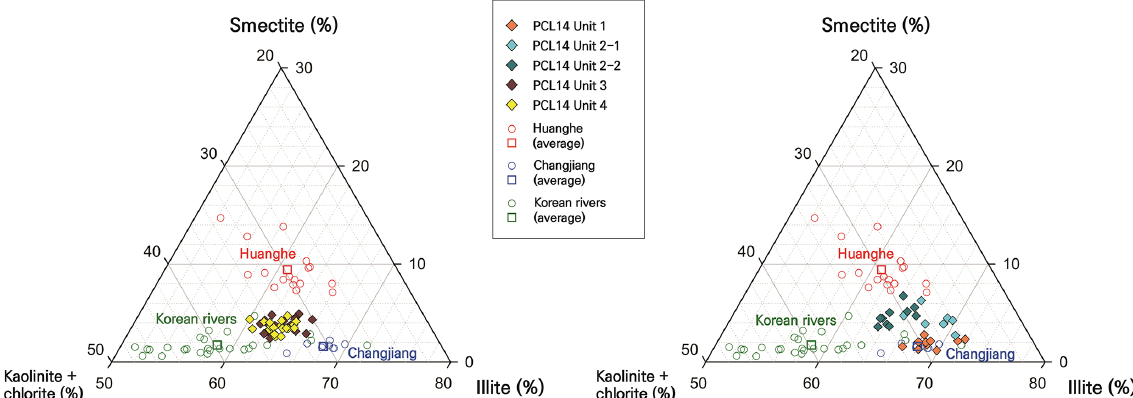
Figure 4. Ternary diagrams showing variations in clay mineral compositions of core 11YS-PCL14. Published data of potential source sediments, including the Changjiang, Huanghe, and western Korean rivers (the Han, Keum, and Yeongsan rivers) (Cho et al., 2015; Koo et al., 2018), which are plotted for